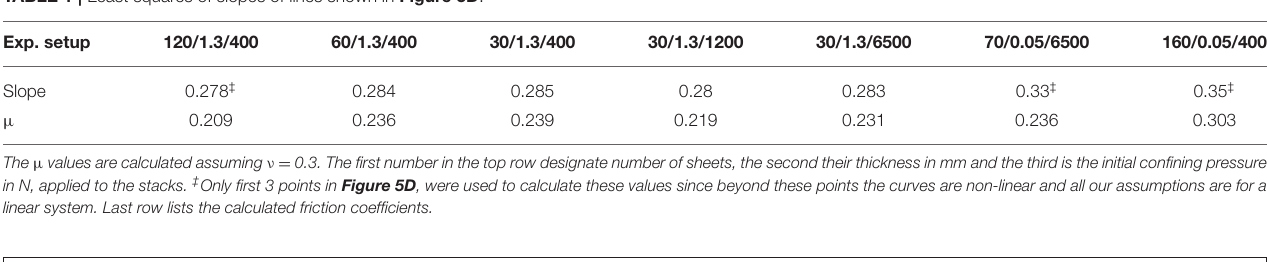
Frontiers in Materials |